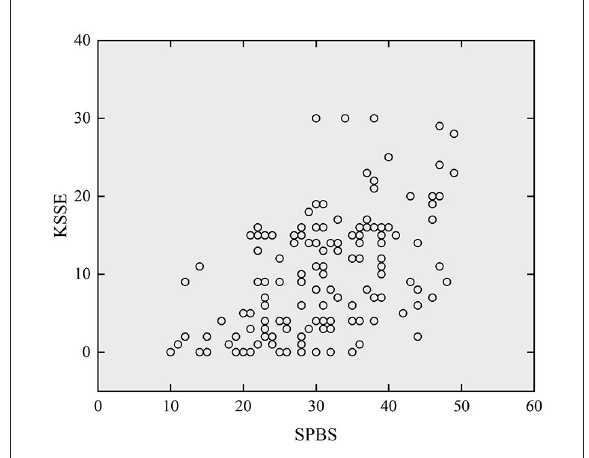
FIGURE2 Scatterplot of SPBS versus KSSE (N = 143).